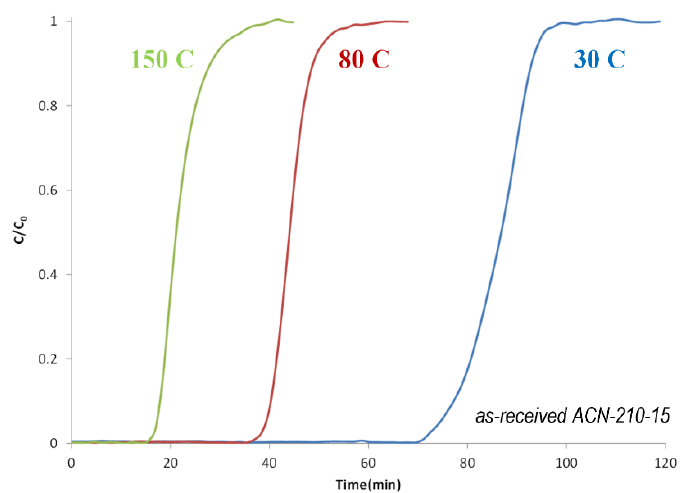
Figure 22. Borazine breakthrough curves as a function of temperature for as-received ACN−210−20.